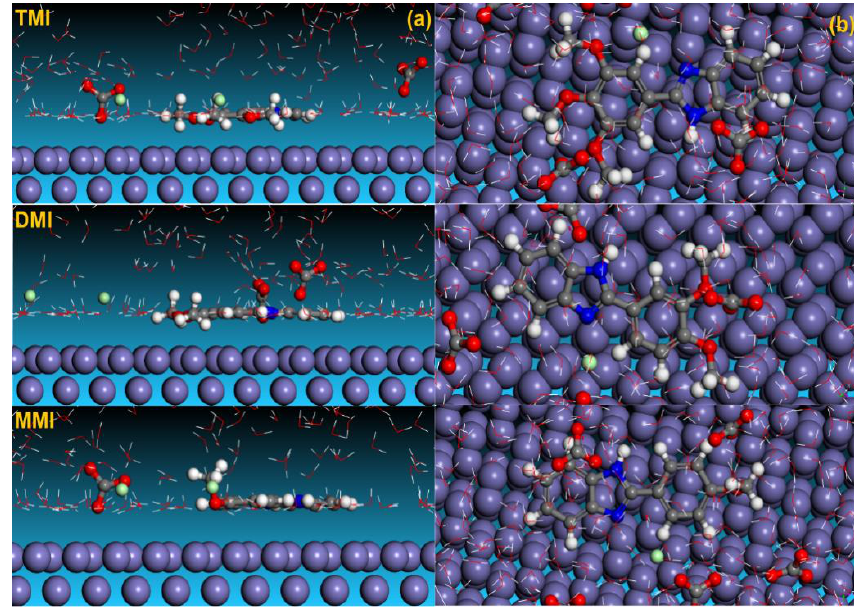
Figure 6. Side and top views of the final adsorption of neutral forms of inhibitor molecules on the Fe (110) surface in solution: ( a ) Side view; ( b ) top view.